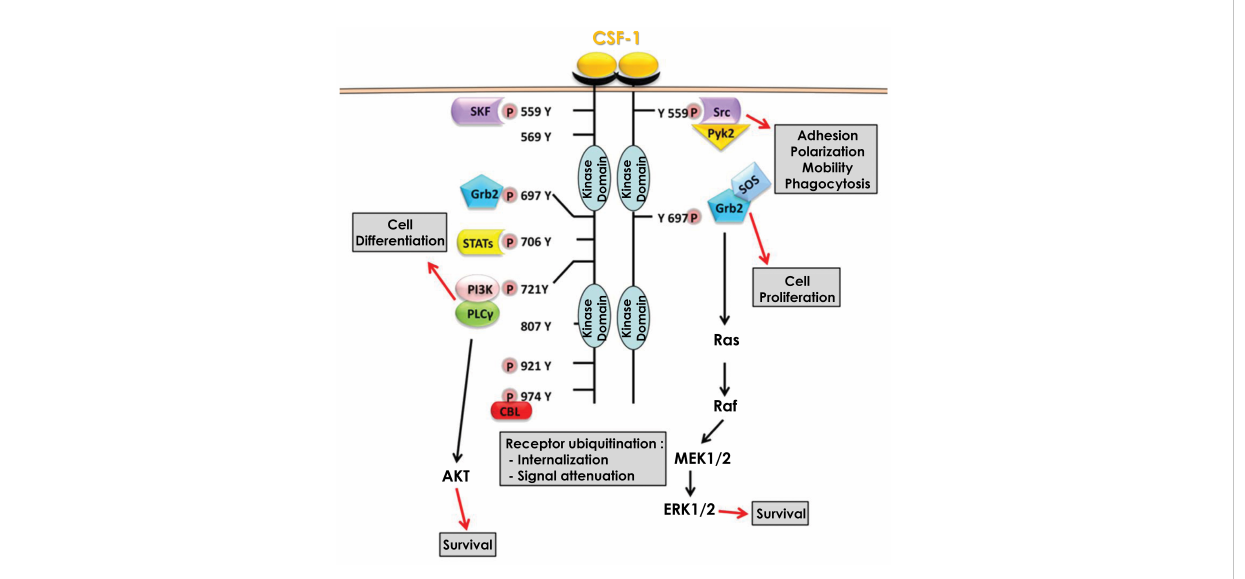
FIGURE 1 Signaling pathways downstream of CSF1R. Binding of CSF-1 to its receptor CSF1R leads to dimerization and subsequent auto-phosphorylation of several tyrosine residues in the intracellular domain. These phosphorylation reactions are then responsible for the activation of multiple signaling pathways that promote cell differentiation and monocyte